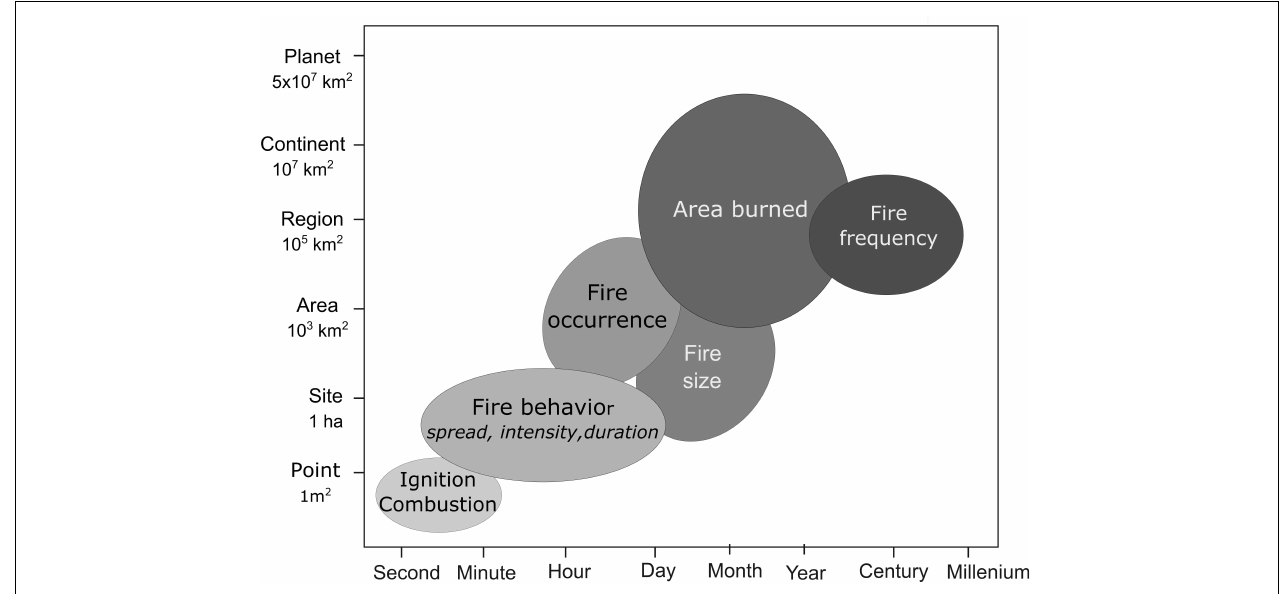
FIGURE 6 | Fire processes are compounded over temporal and spatial scales in an inverse cascade. Redrawn from Taylor et al. (2013).